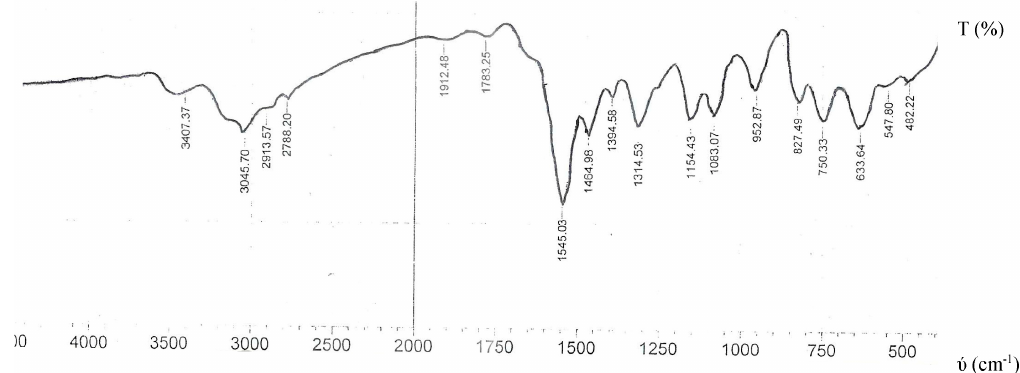
Figure 2. IR spectrum of N -(Benzothiazol-2-yl)-4-chlorobenzenesulphonamide (NBTCS).